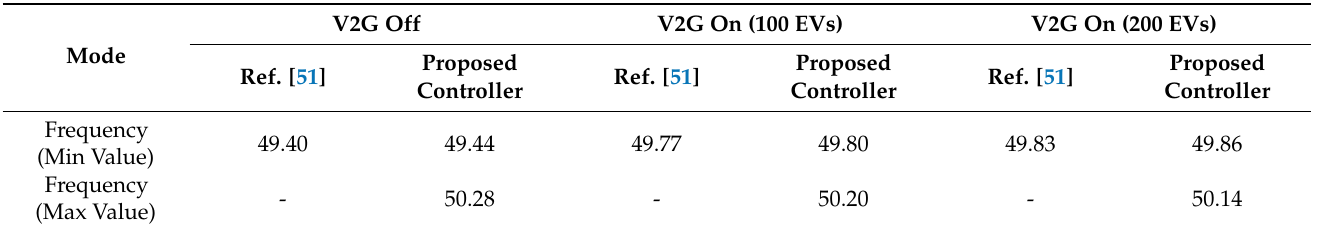
Table 6. Comparison of results for three separate cases in scenario 3 using the proposed controller compared to those of